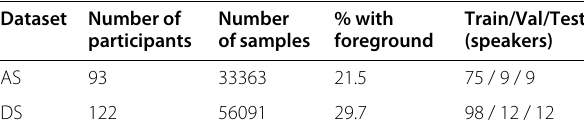
Table 2 Dataset description Dataset Number of